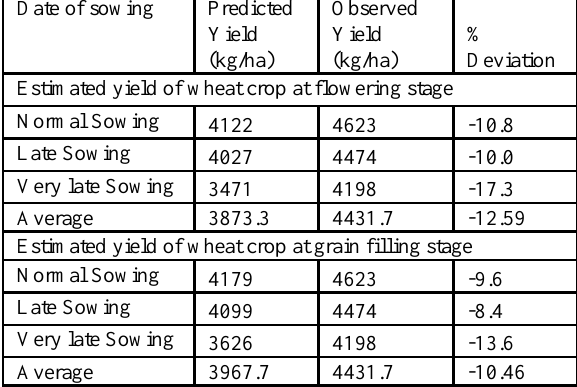
Table 6: Percentage deviation of observed yield from estimated yield of wheat crop by DSSAT model ( Rabi 2017-18) Using InfoCrop model, percentage deviation of estimated yield done at flowering and grain filling stage as compared with the observed yield after harvest was 2.2, 5.6, 3.3 and 2.2, 5.6, -3.6 respectively for normal, late and very late sown crop (Table 5). Percentage deviation of average estimated yield from average observed yield done at flowering and grain filling stage by InfoCrop model was 4.58 and 1.53 respectively. Using DSSAT model the percentage deviation of estimated yield done at flowering and grain filling stage as compared with the observed yield after harvest was -10.8, -10, -17.3 and -9.6, -8.4, -13.6 respectively for normal, late and very late sown crop. Percentage deviation of average estimated yield from average observed yield at flowering and grain filling stage was -12.59 and -10.46 respectively (Table